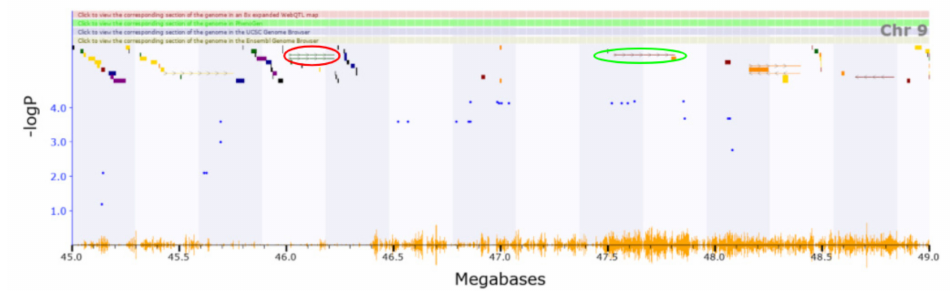
Figure 4. Shown in the red circle (46.22 Mb) is involved in regulating sleep behaviors. Cadm1 shown in the green circle (47.55 Mb) is associated with increased anxiety, impaired social and emotional behaviors, and disrupted motor coordination in knockout